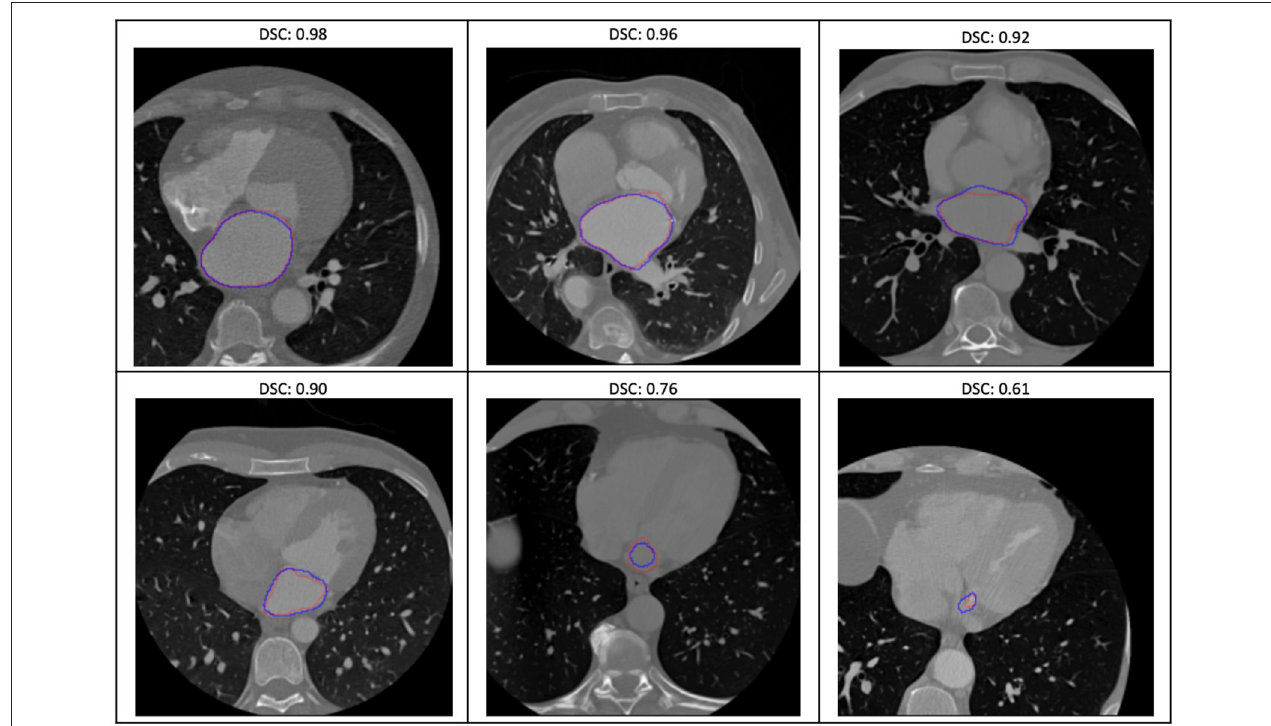
FIGURE 5 | Some examples of the variable prediction of the segmentation model (the red and blue contours represent the label and prediction and the corresponding dice scores are shown on the top of each image).